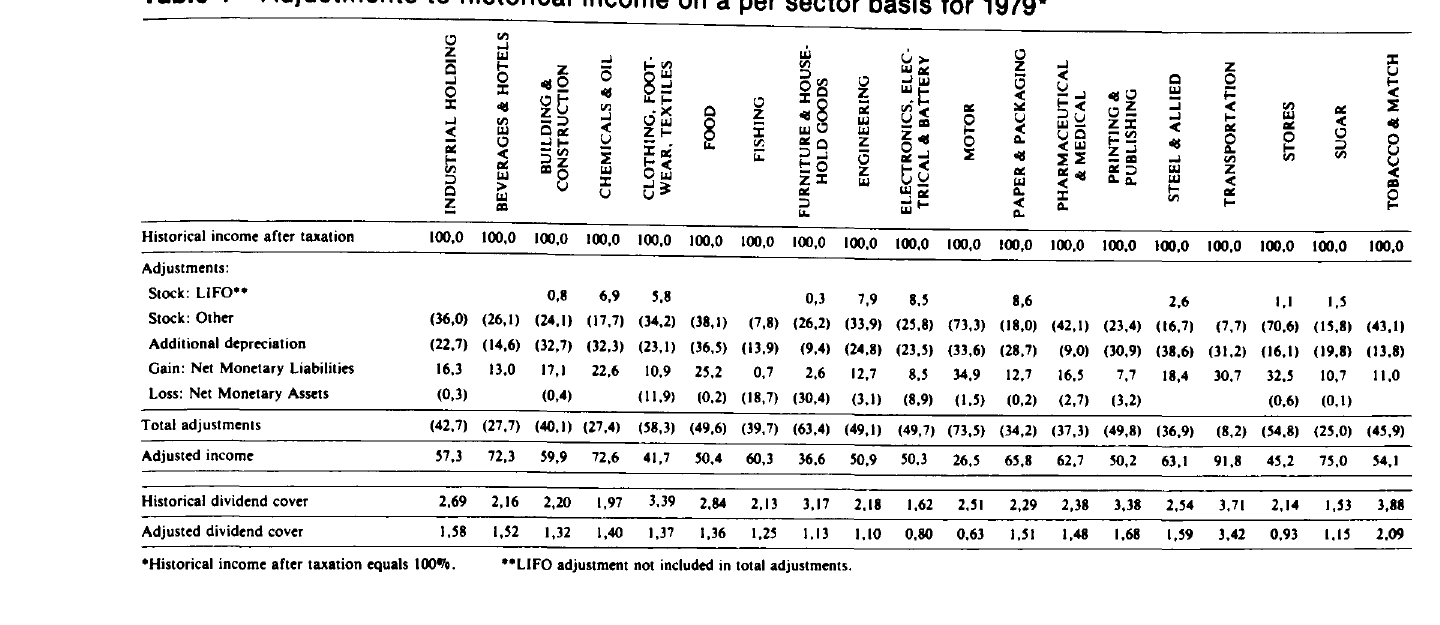
Table 1 Adjustments to historical income on a per sector basis for 1979* 0 "' ..J